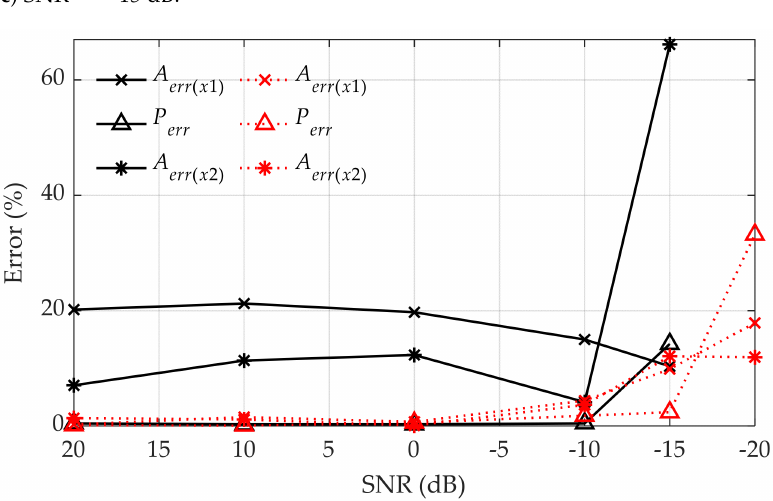
Figure 9. Comparison of errors (Red: CD-SR, Black: